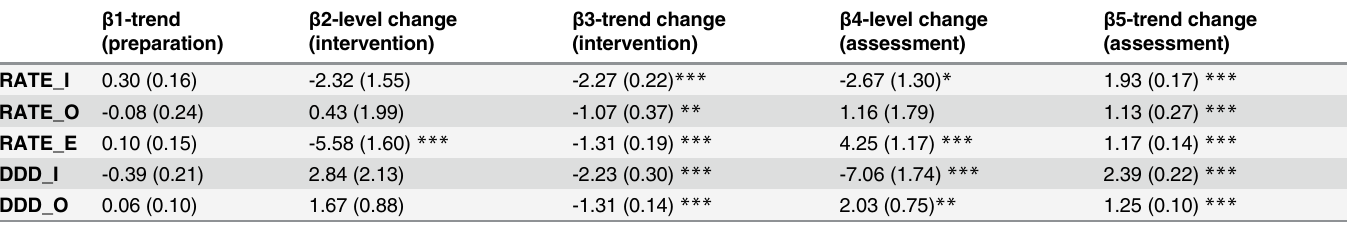
Table 1. Regression analyses of ITS on the changes in antibiotic